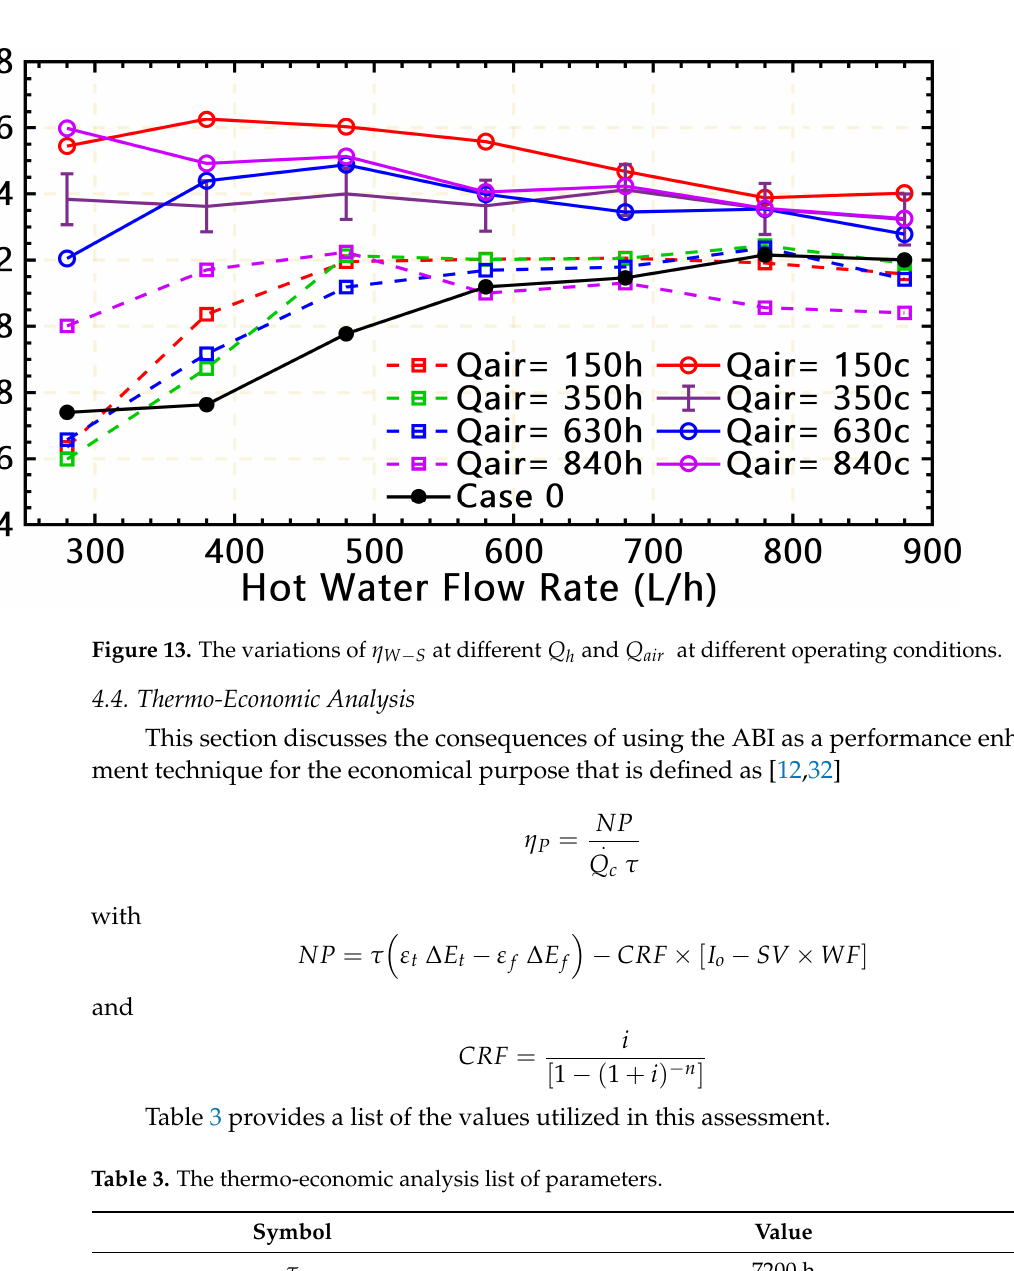
18 of 24 Figure 12. Relationship between 𝜀 (cid:3032)(cid:3051) and 𝑄 (cid:3035) for original case and, different ABI into both CWS and HWS. 4.3.2. Witte-Shamsundar Efficiency The efficiency of energy usage can be evaluated using Witte-Shamsundar efficiency according to the second law analysis, as depicted in Figure 13. ABI has superiority in en- hancing the efficiency of all the testing conditions with a maximum value of 0.986 for 𝑄 (cid:3028)(cid:3036)(cid:3045) = 150 L/h and 𝑄 (cid:3035) = 380 L/h into CWS, at this tested condition the entropy generation rate has a minimum value of 0.0382 W/K. Furthermore, these effects are extended also to ABI into HWS but with deterioration at high 𝑄 (cid:3035) of 880 L/h. Although the maximum improve-